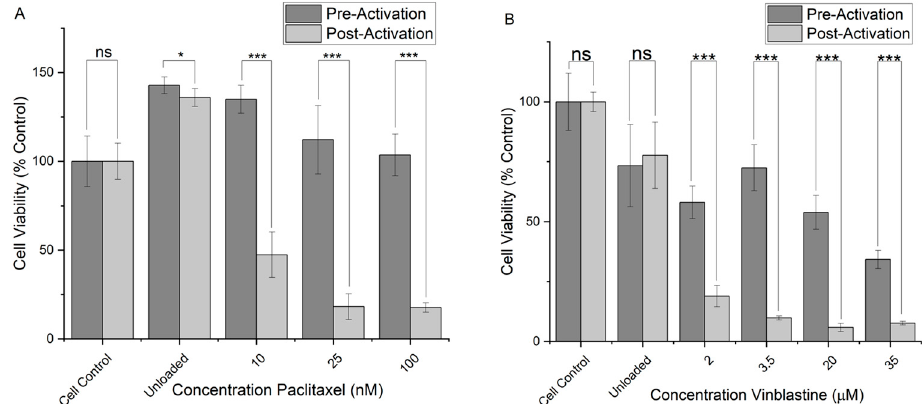
Figure 7. Cell viability was assessed by delivering chemotherapy agents to cells in vitro. The NCC was used to deliver paclitaxel and vinblastine to ( A ) RD cells, and ( B ) U-87 MG cells; the x-axis represents concentrations of drugs carried and released by the NCC. Cells refer to the cell-only control and are set to 100%. Unloaded refers to cells incubated with a 2 mg/mL solution of the NCC without bound drugs. All data are scaled as a percentage of cell survival normalized to the cell-only control. Significance was tested using a two-tailed t -test compared between pre- and post-activation for each concentration. P-values assessed between pre- and post-activation are represented as follows *** = p < 0.01, * = 0.5 < p > 0.05, ns = p > 0.5. Bars represent mean +/ − standard deviation, n = 3.